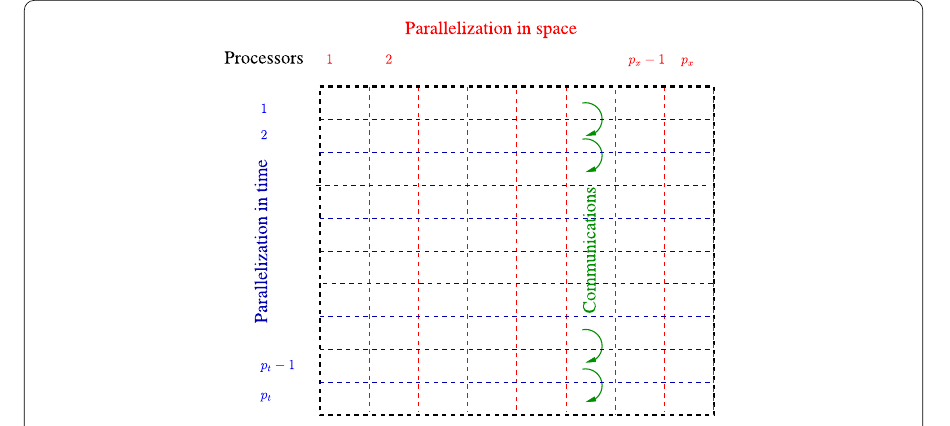
Figure 6 Parallelization in space and